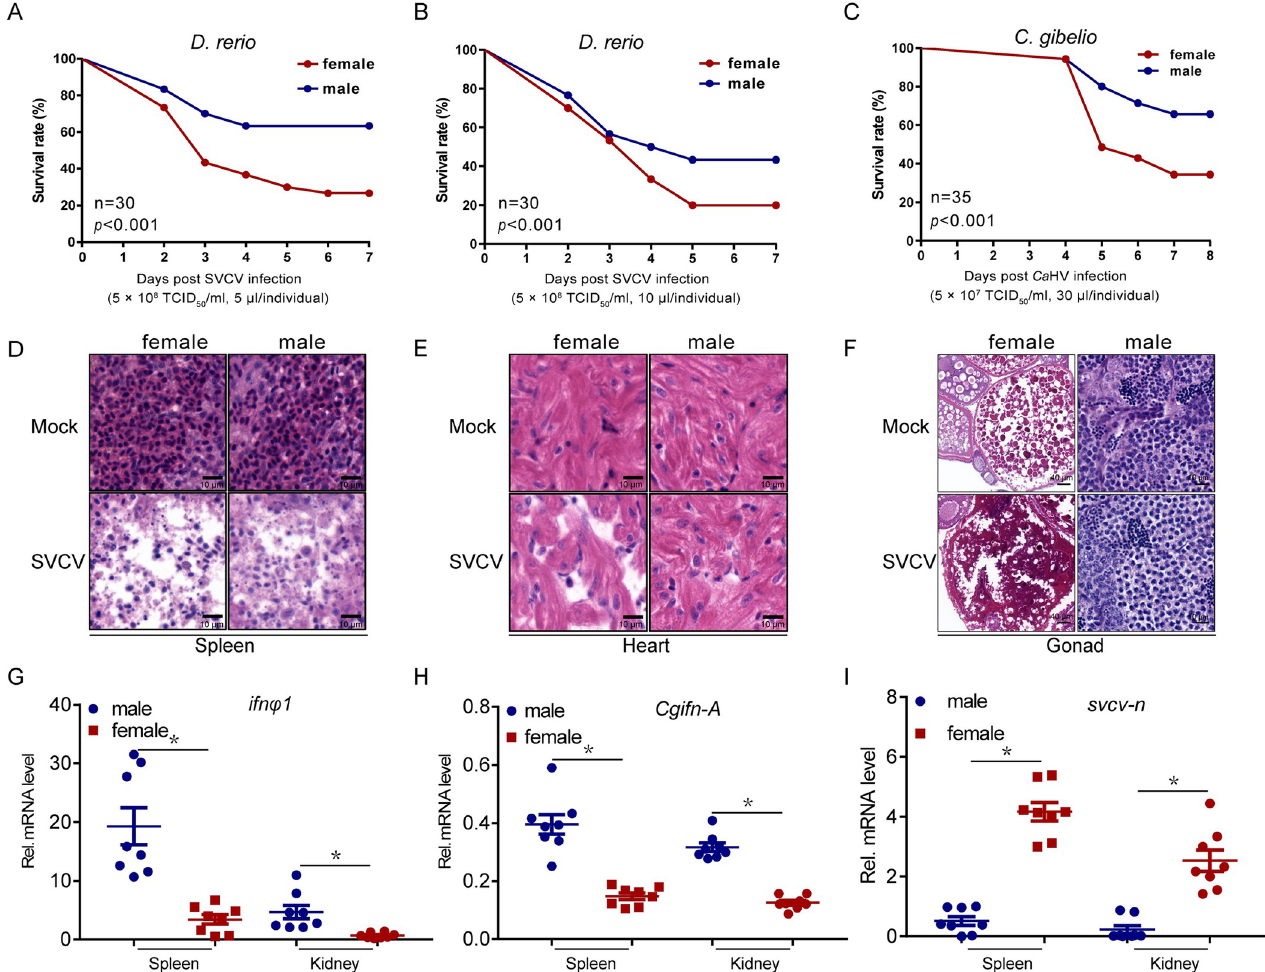
Fig 1. Sex-dependent fish susceptibility to mortality by SVCV infection. (A-B) Survival (Kaplan-Meier Curve) of male and female zebrafish (n = 30 per group) at various days after i.p. injected with SVCV (5 × 10 8 TCID 50 /ml, 5 μ l or 10 μ l/individual). (C) Wild-type Male and female gibel carp (n = 35 per group) were i.p. injected with Ca HV (5 × 10 7 TCID 50 /ml, 30 μ l/individual) and the survival rate was calculated. (D-F) Microscopy of H&E-stained spleen (D), heart (E), and gonad (F) sections from male and female zebrafish treated with SVCV (5 × 10 8 TCID 50 /ml, 5 μ l/individual) for 72 h. (G) qPCR analysis of ifnφ1 mRNA in the spleen and kidney of male and female zebrafish (n = 8 per group) given i.p. injection of SVCV (5 × 10 8 TCID 50 /ml, 5 μ l/individual) for 48 h. Each dot point represents one independent biological replicate. � p < 0.05. (H) qPCR analysis of Cgifn-A mRNA in the spleen and kidney of male and female gibel carp (n = 8 per group) given i.p. injection of Ca HV (5 × 10 7 TCID 50 /ml, 30 μ l/individual) for 48 h. Each dot point represents one independent biological replicate. � p < 0.05. (I) qPCR analysis of svcv-n mRNA in the spleen and kidney of zebrafish (n = 8 per group) given i.p. injection of SVCV (5 × 10 8 TCID 50 /ml, 5 μ l/individual) for 48 h. � p <